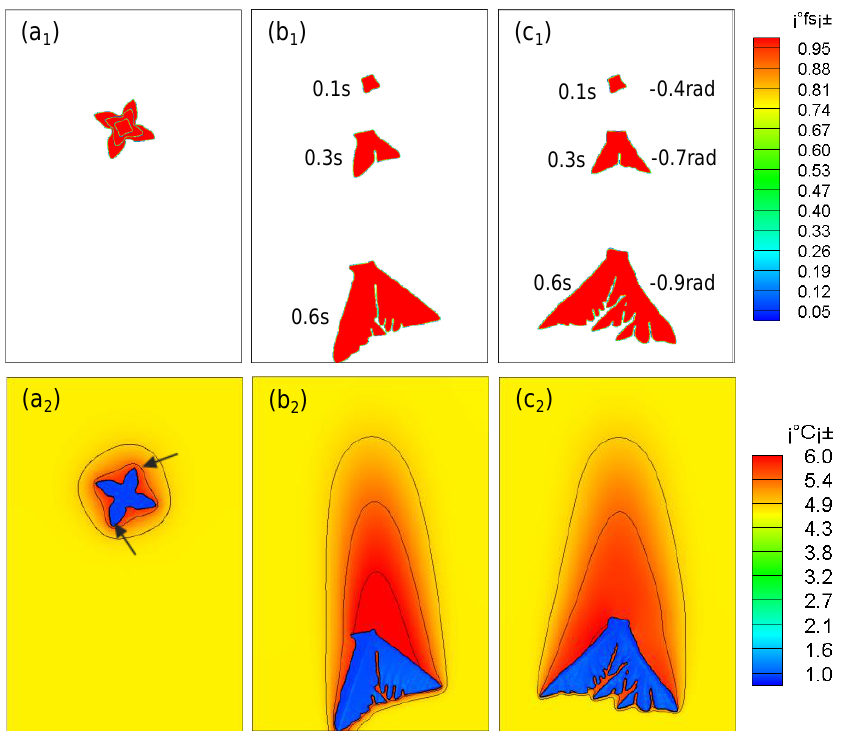
Figure 6. Effects of different motion states on dendrite growth. ( a 1 ), ( b 1 ), ( c 1 ) the growth morphology diagram of dendrite under the condition of stationary, translational falling without rotation, and rotational falling; ( a 2 ), ( b 2 ), ( c 2 ) the solute distribution diagram of dendrite under the condition of stationary, translational falling without rotation, and rotational falling. Crystals 2019 , 9 , x FOR PEER